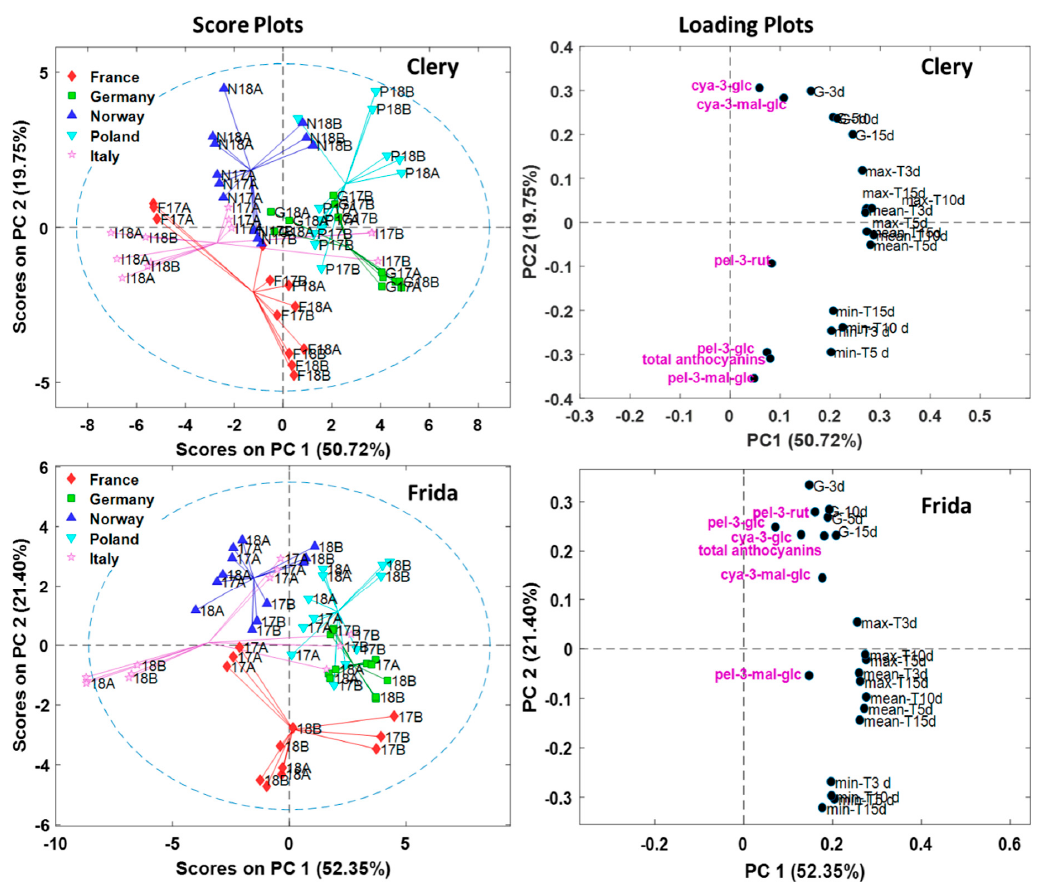
Figure 2. Score and loading plots of PCA for ‘Clery’, and ‘Frida’ grown at five locations (F: France; G: Germany; N: Norway; P: Poland and I: Italy) characterized by total and individual anthocyanin and climatic data. The number and capital letters in the different panel are referring to the year (2017 and 2018, labeled as 17 and 18) and A or B to the harvest date, being one week apart.